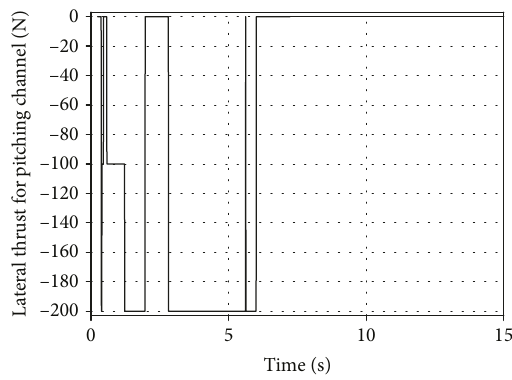
Figure 8: Variation of lateral thrust P